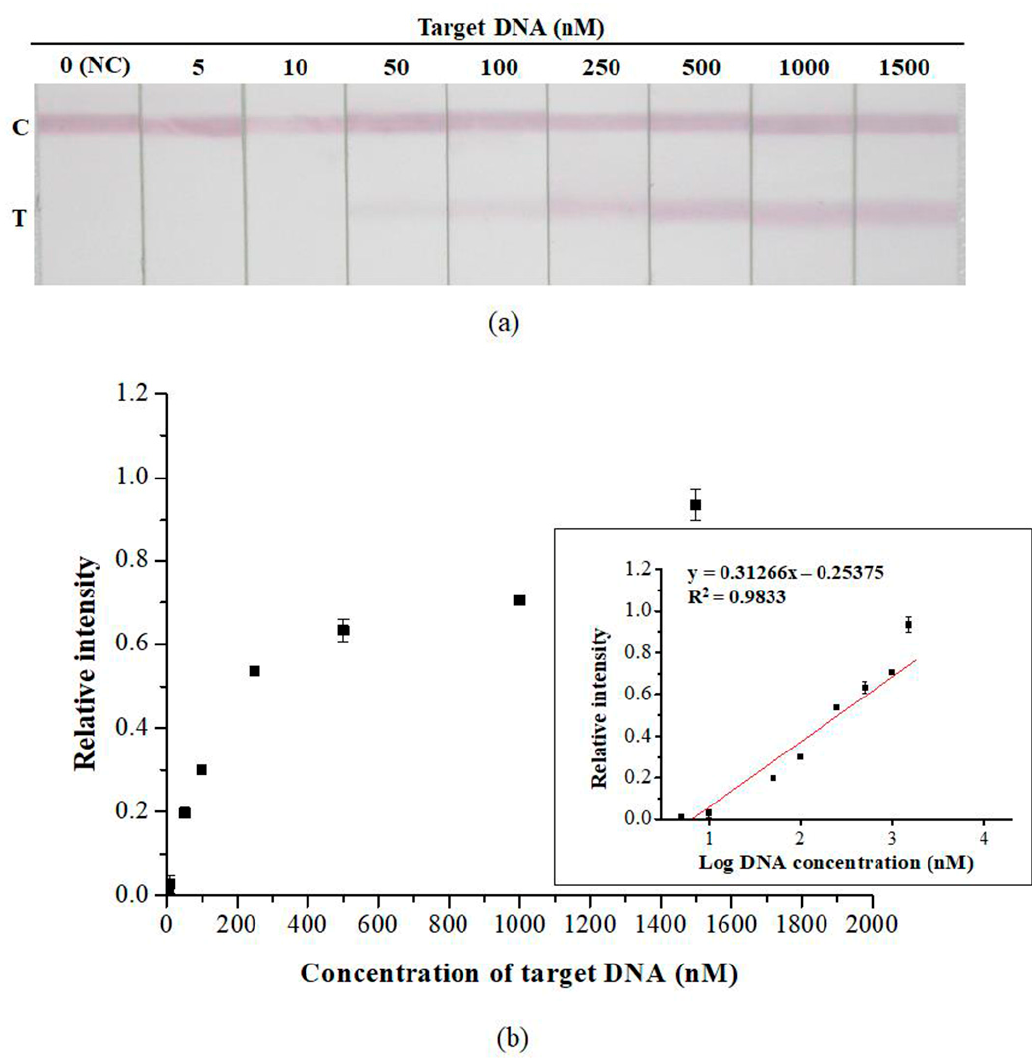
Figure 5. Sensitivity assay of the developed lateral flow strip. ( a ) Photographic images of the developed lateral flow strip in the presence of various DNA concentrations. ( b ) Resulting calibration curve of ( a ). Data are presented as the mean and SD. NC: negative control.